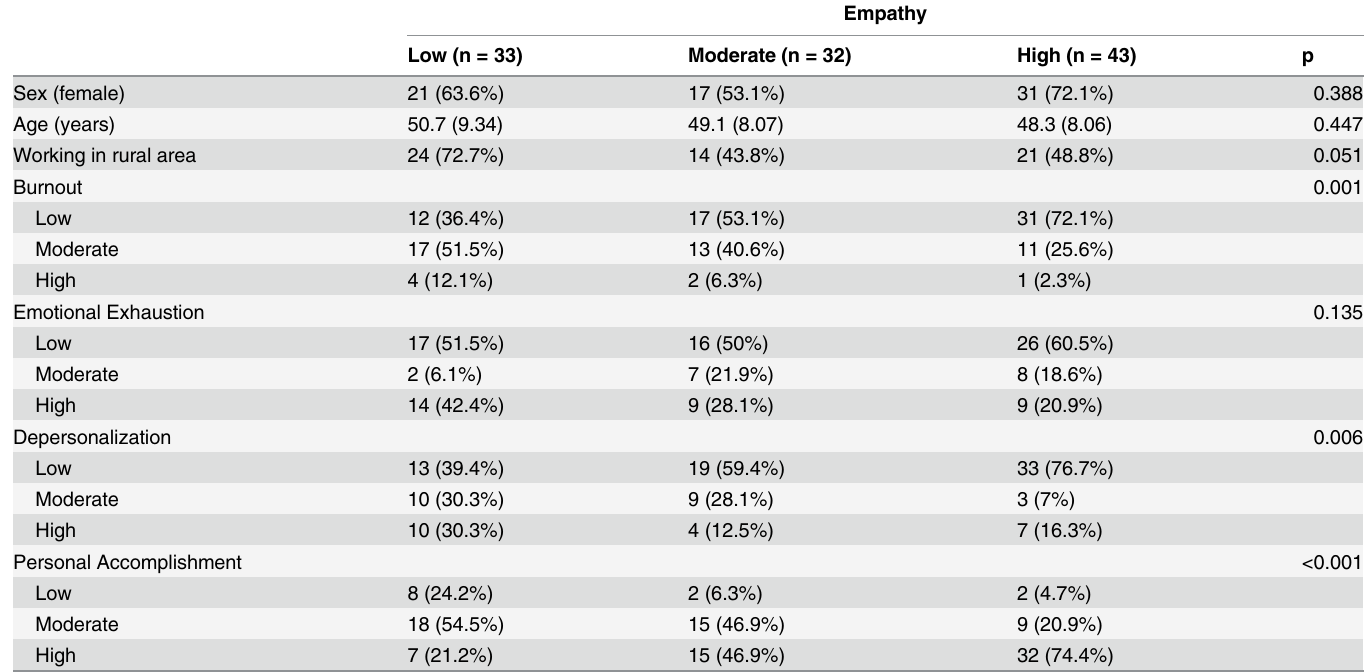
Table 1. Association between empathy and sociodemographic variables and burnout.